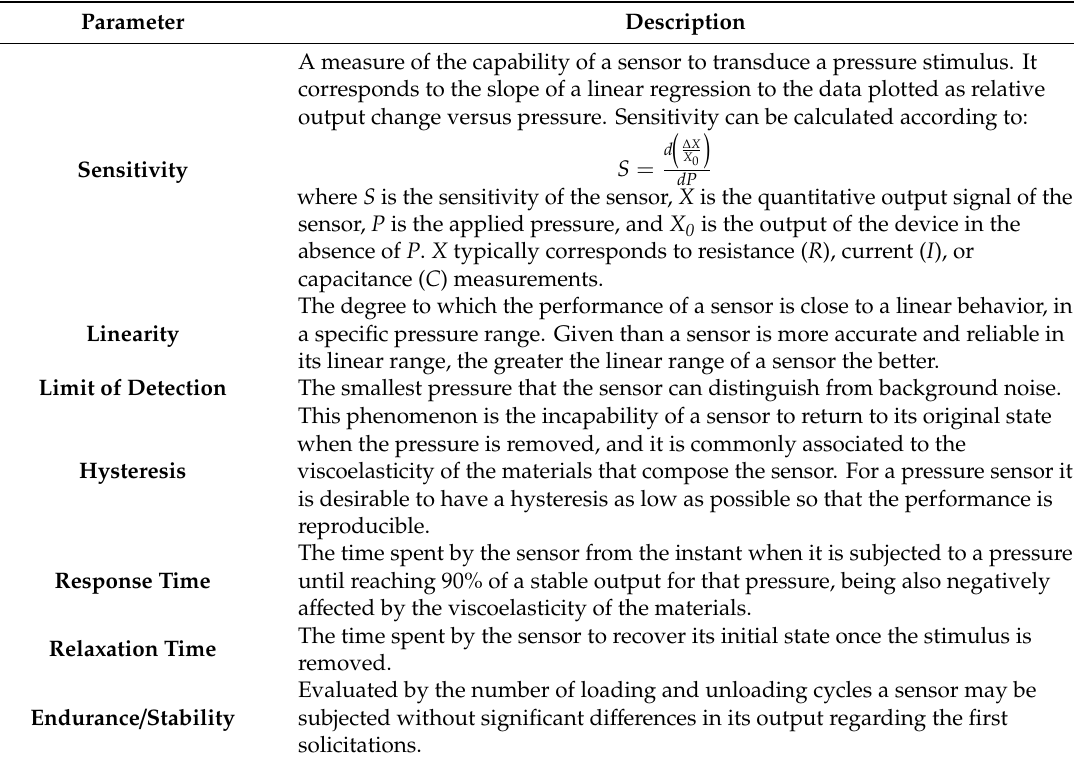
Table A1. Key parameters to characterize a pressure sensor